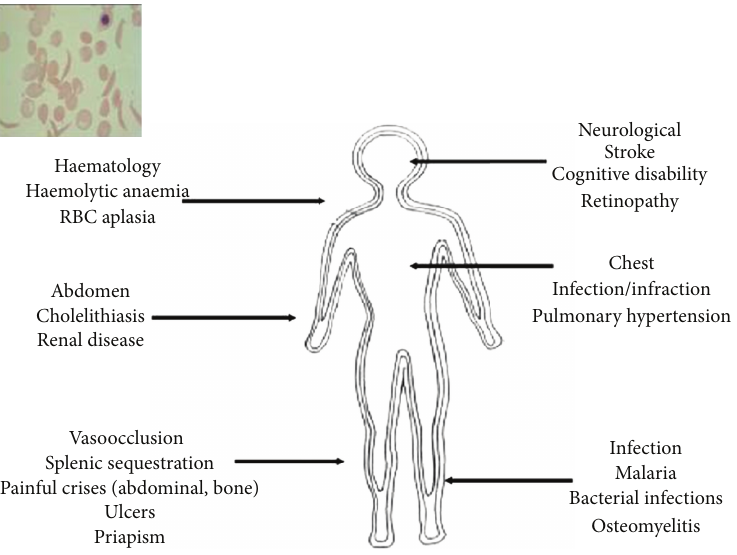
Figure 2: Selected clinical consequences of